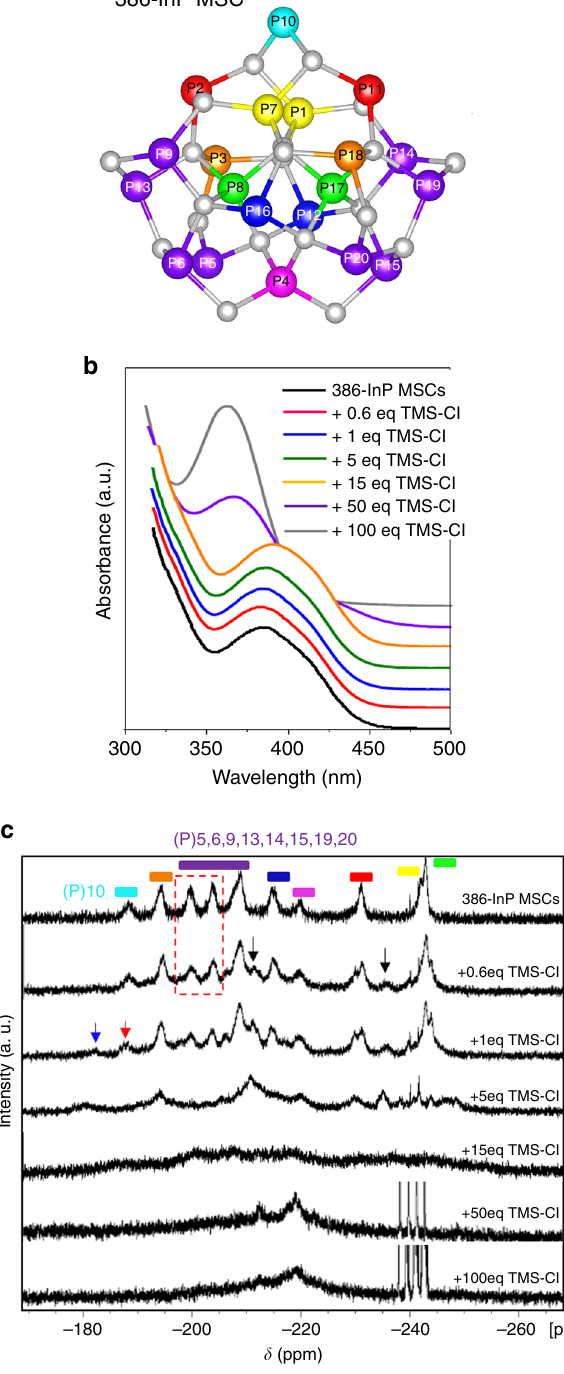
Fig. 4 Early-stage conversion from 386-InP MSC to F360-InP:Cl MSCs. a The view of In 21 P 20 3 + core structure in 386-InP MSC. The structural fi gure of 386-InP MSC was drawn using reported crystallographic information fi le 13 . b Evolution of UV – vis absorption spectra of 386-OA InP MSCs with addition of TMS-Cl of 0.6, 1, 5, 15, 50, and 100 equivalents, relative to 386- InP MSC in toluene-d8. c Evolution in 31 P{ 1 H} NMR spectra of 386-OA InP MSCs upon the TMS-Cl addition; colored bars at top: represent corresponding phosphorus atoms of the same color in a . (Dotted red box: reduction of the peaks, black arrows: peaks emerging at + 0.6 eq. addition, red arrow: P10 peak, blue arrow: peak emerging at + 1 eq.